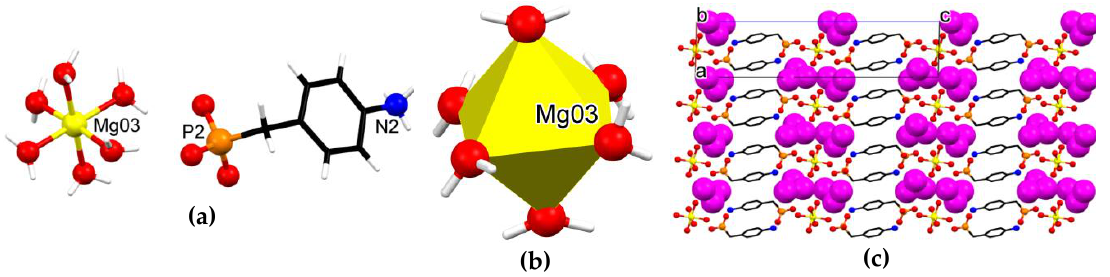
Figure 2. Crystal structure of Mg-PABPA: ( a ) View of the cation-anion pair; ( b ) The [Mg(H 2 O) 6 ] 2 + polyhedron; ( c ) Packing along the b axis. Lattice waters are shown as magenta spheres.